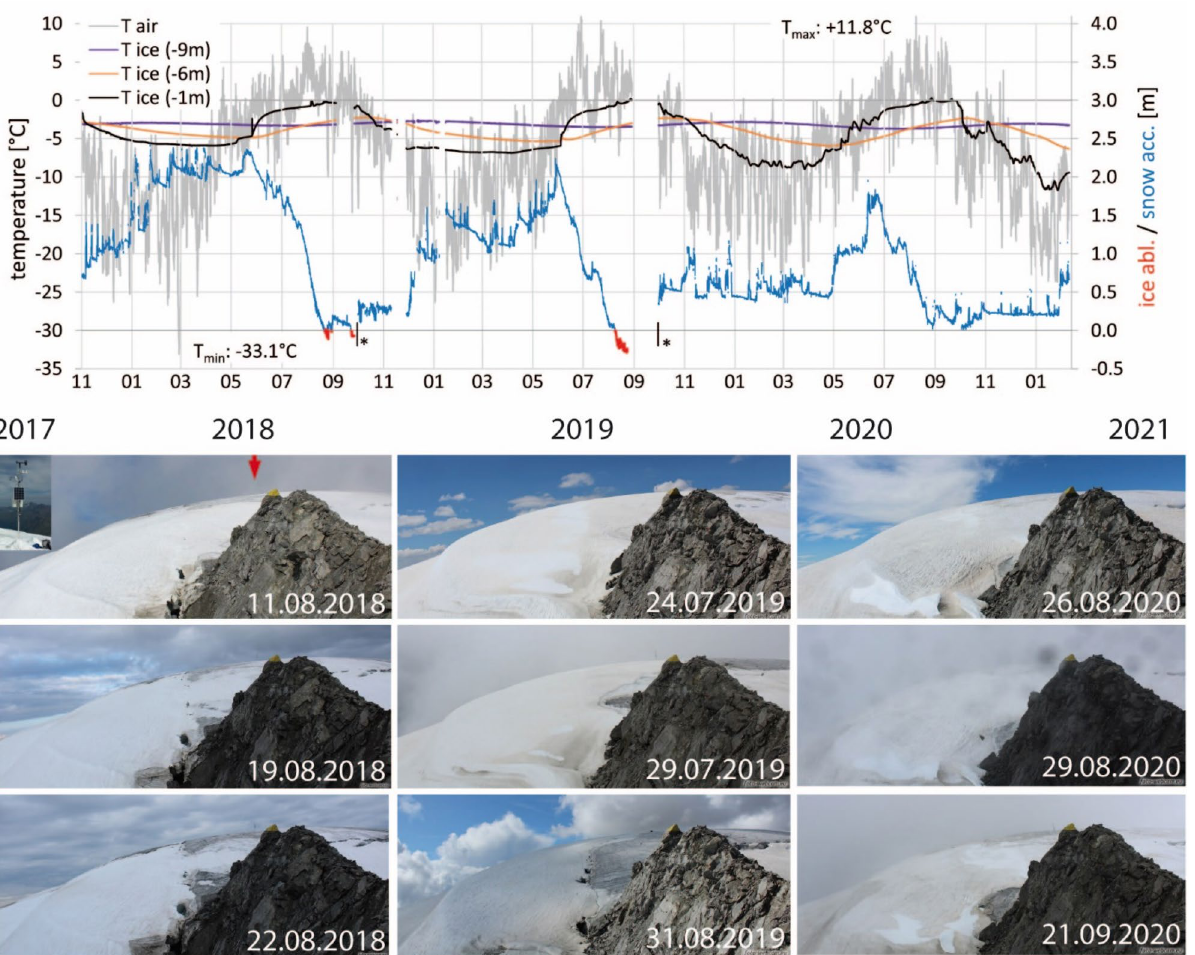
Figure 2. Air temperature (T air) and ice temperatures (T ice) at different depths related to the 2017 ice surface, from November 2017 to February 2021, as well as the minimum and maximum temperature for the whole period. Snow accumulation and ice ablation measured with the sonic ranging sensor refer to the right ordinate axis. Ice ablation (red lines) took place from 22.08.2018 to 27.08.2018 and 09.08.2019 to 31.08.2019 2019 (end of period reconstructed from camera images) (*). In 2020, no ice melted at the location of the AWS. New distance to surface correction of the sonic ranging sensor sets the ice surface to zero. The pattern of mass balance is visible on the time-lapse camera images (positon of the AWS indicated by the red arrow).